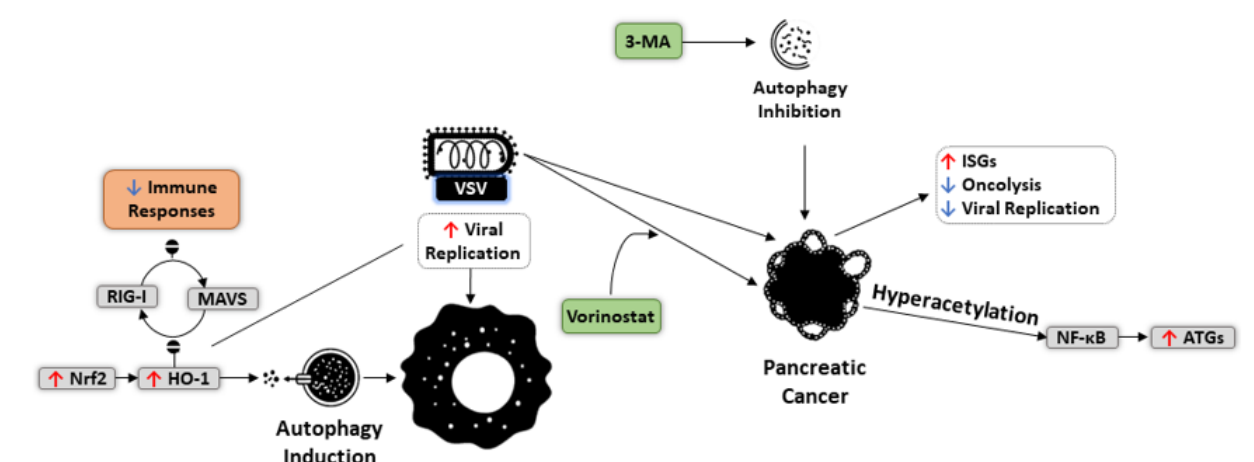
Figure 6. Impact of autophagy induction on the replication of oncolytic vesicular stomatitis Indiana virus (VSV). Activation of autophagy by Nrf2 pathways not only suppresses immune responses by blocking RIG-1-MAVS interactions but also elevates VSV replication in cancer cells. Combining VSV with vorinostat in pancreatic cancer cells can increase the hyperacetylation of NF-κB, ultimately promoting the expression of ATG genes.